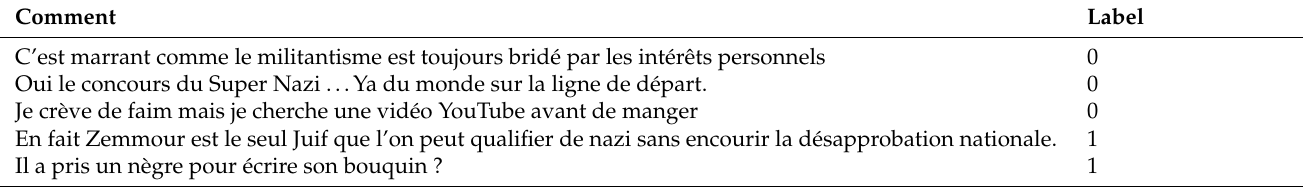
Table 2. A snippet of the FTR